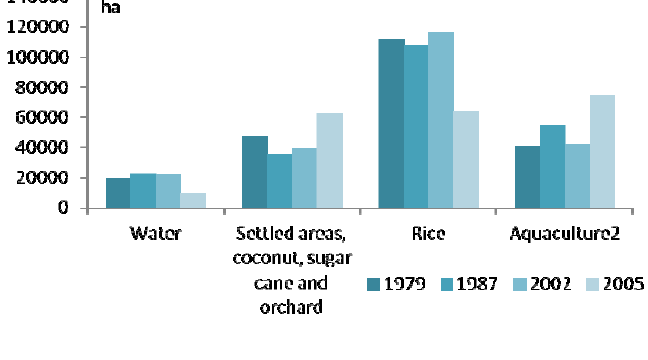
Figure 7. The overall land use in Tra Vinh province based on optical images for years 1979, 1987, 2002 and